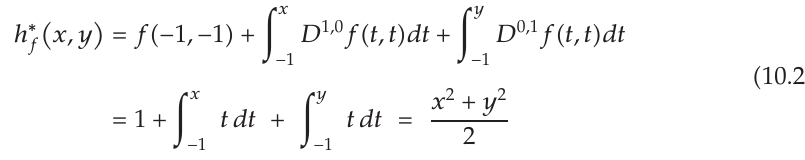
(cid:3) x,y (cid:4) f